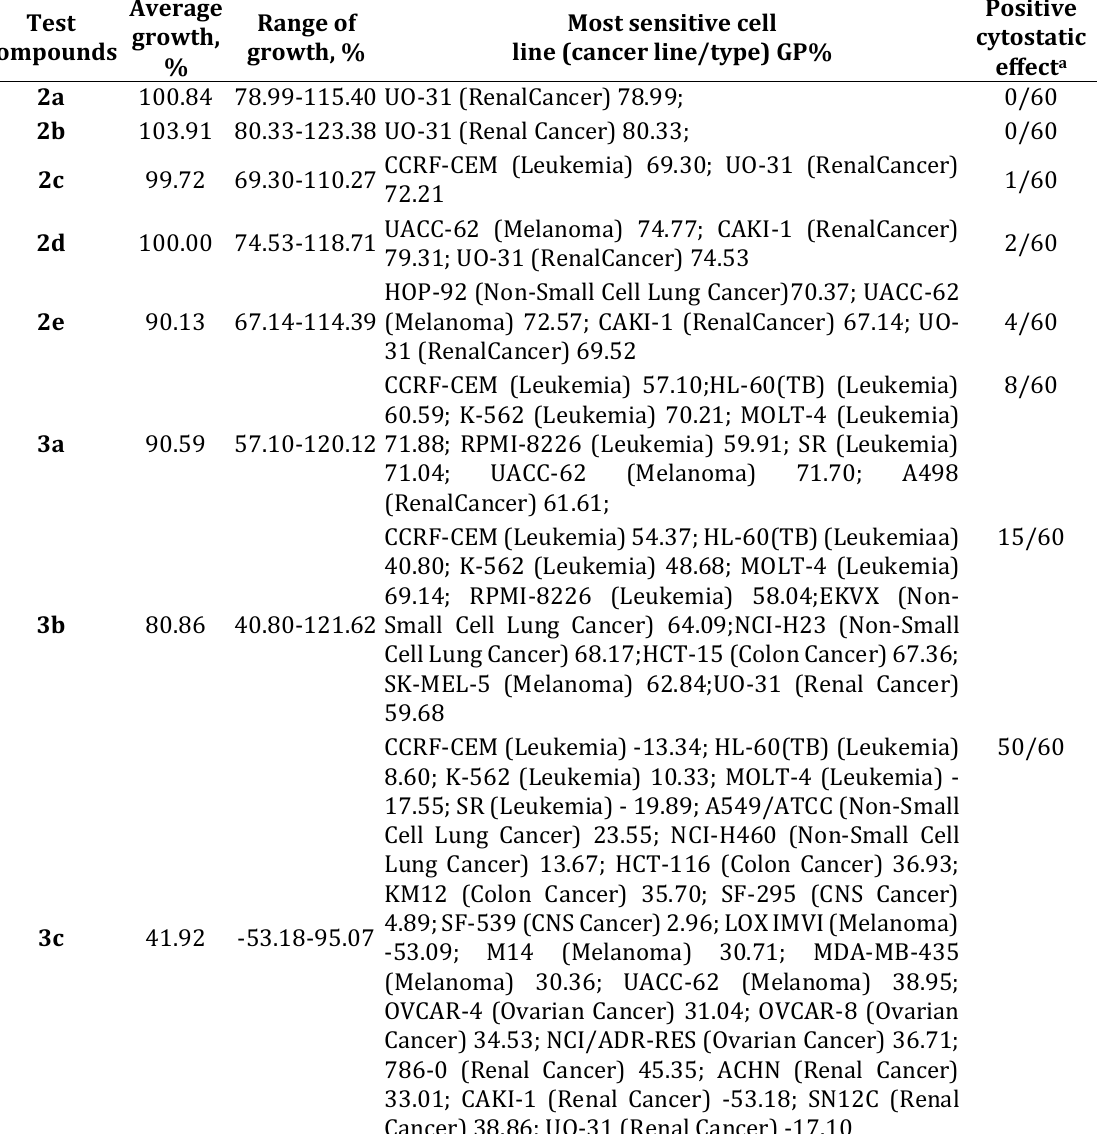
a Ratio between number of cell lines with percent growth from 0 to75 and total number of cell